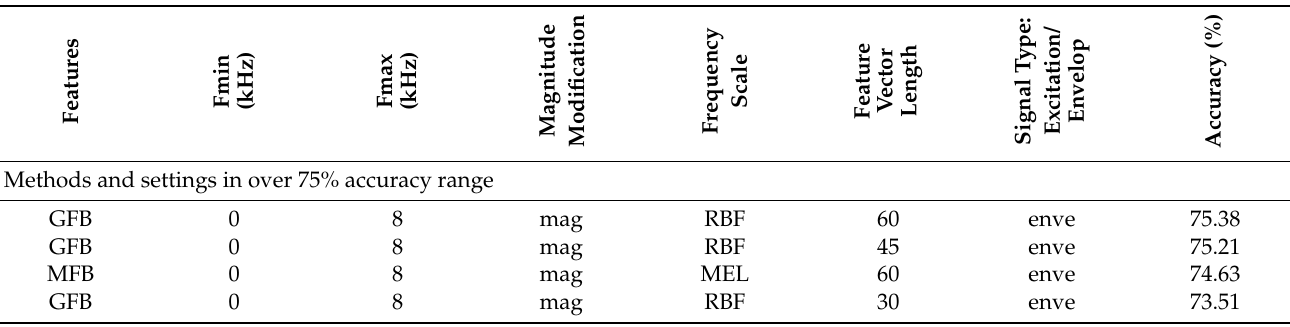
Table 2. Methods and settings being in 75% and 70% accuracy ranges at the 10% significance level sorted in descending order (Berlin